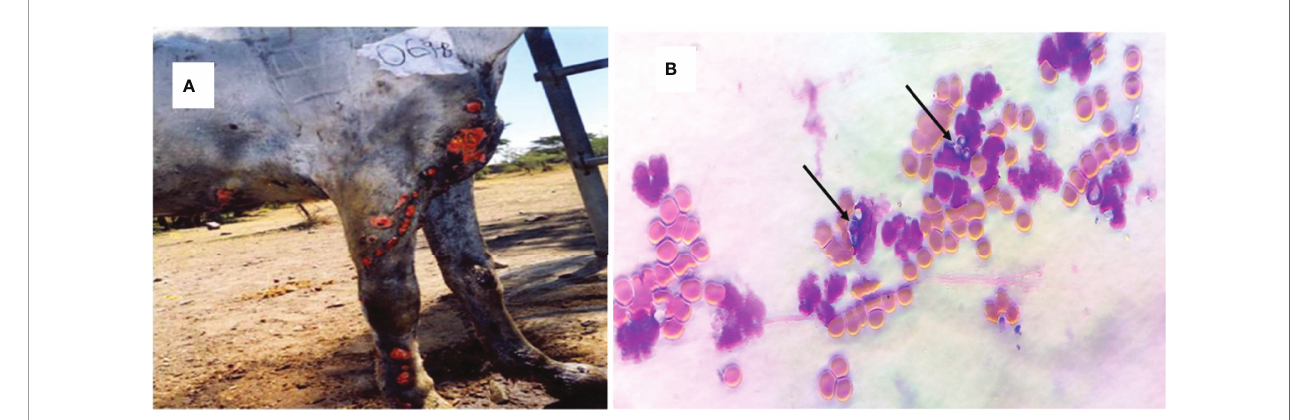
FIGURE 1 | Clinical epizootic lymphangitis case of a carthorse and the yeast form of H. capsulatum var. farciminosum in central Ethiopia. (A) Granulomatous in fl ammation of the lymphatic vessels, the regional lymph nodes, and the skin of the fore limbs; as the disease progressed, the nodules ulcerated and formed ulcers. (B) Giemsa-stained yeast form of H. capsulatum var. farciminosum obtained from nodular aspirate and observed under microscope at ×100 with oil immersion. The yeast cells are shown by arrow; the purple cells are granulocytes while the orange cells are red blood